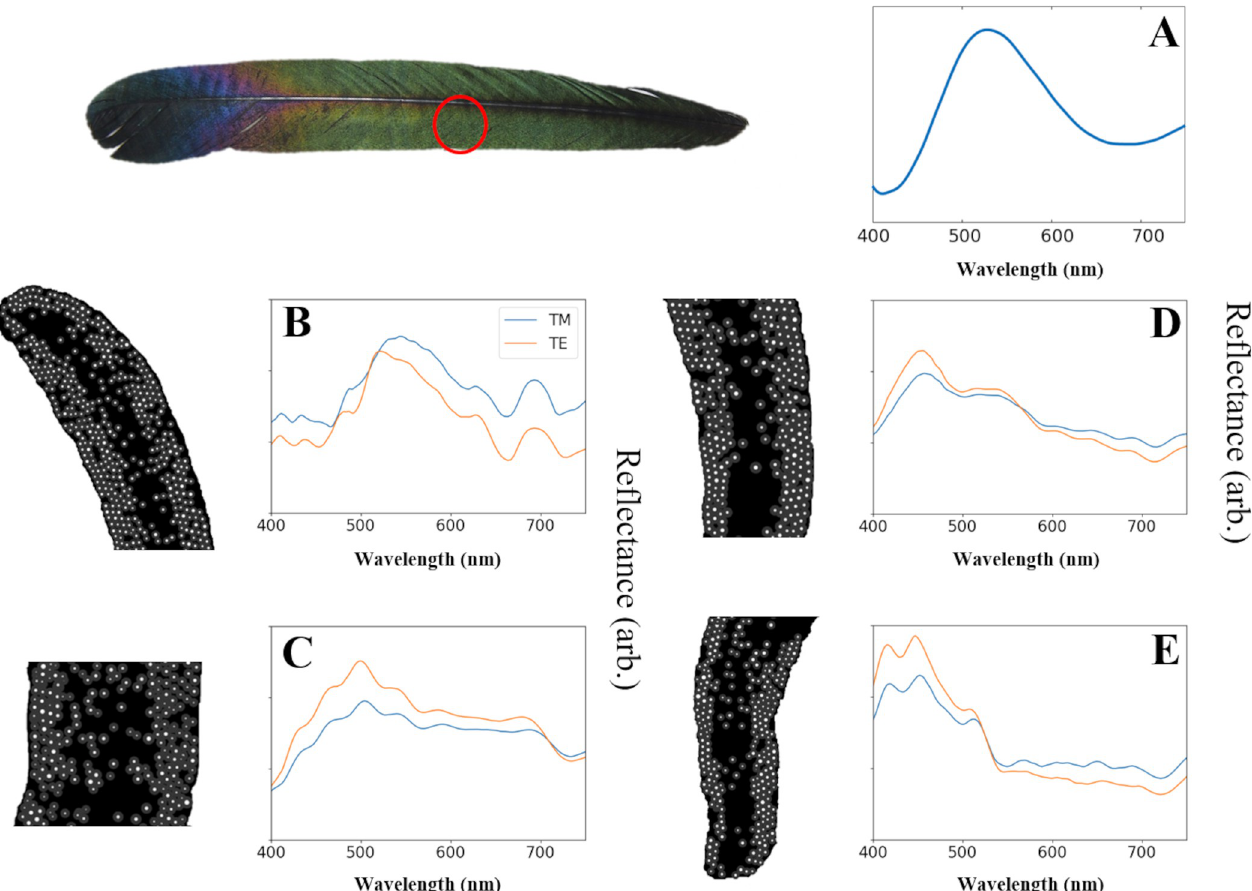
Fig 3. Reflectance spectra measured using the experimental setup and calculated using FDTD simulations. A Reflectance spectra of the barbule in the green area indicated by the red circle measured using the experimental setup. The wide spectrum has a dominant peak at about 520 nm. B − E Spectra calculated using FDTD simulations. The keratin, melanin, and air are represented by black, gray, and white in the simulated images, respectively. The refractive indices for keratin and air are 1.55 and 1.00 [25]. The refractive index of melanin was taken from Stavenga et al. [25] and fit with a Lorentzian function. The B and C spectra agree well with the experimental spectra, while the D and E spectra differ. The solid blue and orange lines represent TE and TM mode, respectively.